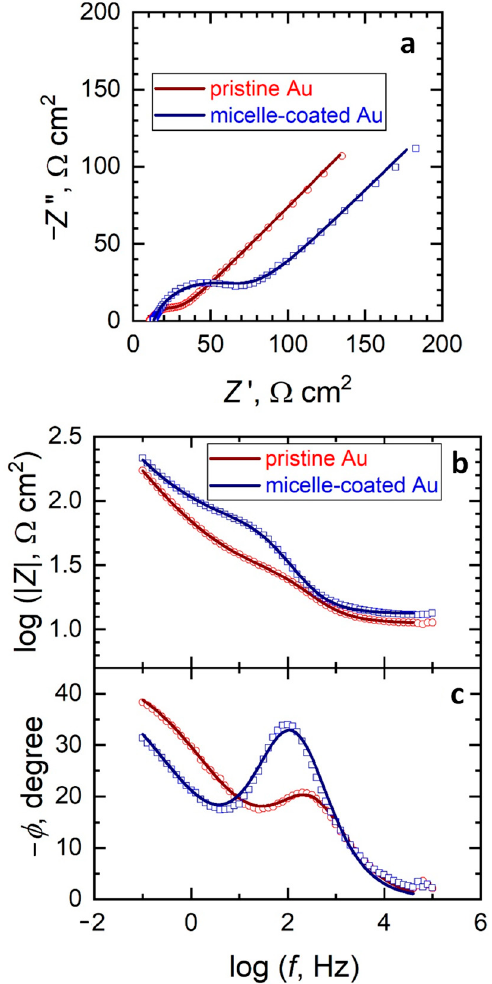
Figure 6. ( a ) Nyquist and ( b , c ) Bode diagrams of the impedance spectra of pristine and micelle- modified gold in 0.1 M KCl + 1 mM K 3 Fe(CN) 6 . The solid lines and the discrete points correspond to the fitted and the measured data, respectively.